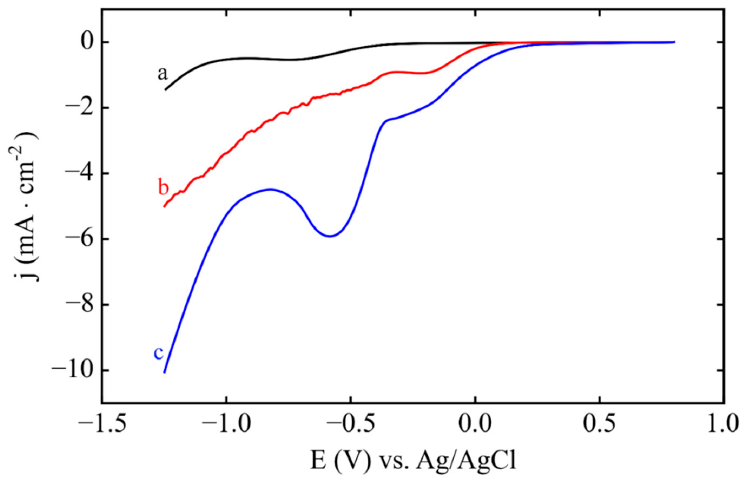
Figure 3. Linear sweep voltammetry of 3 independently prepared HOPG surfaces in 3 mM H 2 PtCl 6 0.5 M NaCl pH 2.3 (a–c), ν = 100 mV/s.